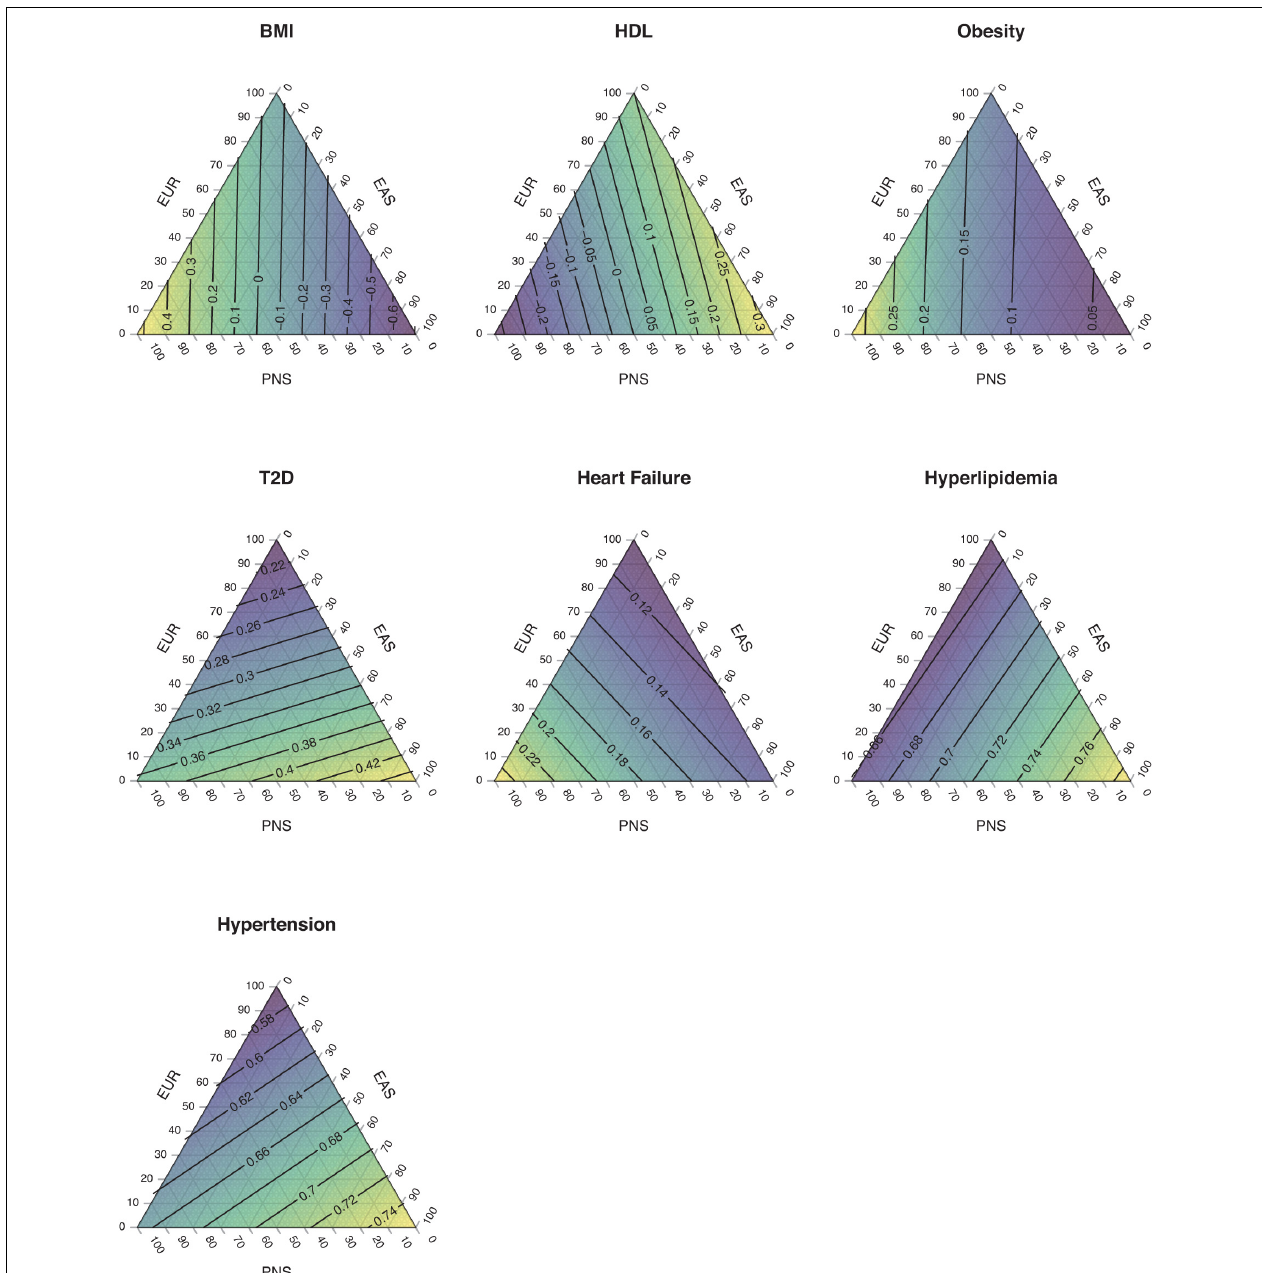
FIGURE 1 | Impact of ancestry components on complex traits and disease risks in Native Hawaiians. The distribution of estimated disease risk are shown as a function of a three-component ancestry model. The linear models used were described in Sun et al. (2021), where for each trait examined as the dependent variable, the effect sizes of the relevant independent variables (e.g., age, BMI, and estimated genetic ancestry as scalar variables, or education level as the categorical variable) were estimated from a Native Hawaiian cohort. Quantitative (BMI and HDL) traits were modeled using linear regression, which predicts the estimated trait value in units of standard deviations given the genetic ancestries. Binary [obesity, type 2 diabetes (T2D), heart failure, hyperlipidemia, and hypertension] traits were modeled using logistic regression, which predicts the probability of disease given genetic ancestries and other covariates. An adult male with age = 50 years, BMI = 30 units (excluded from the obesity model), and education level = college graduate was assumed for calculating probability of disease or estimated trait value. For simplicity, a three-component ancestry model with contributions only from European (EUR), East Asian (EAS), and Polynesian (PNS) ancestors was assumed for Native Hawaiians. The predicted values were interpolated across all possible combinations of ancestries and shown with contour lines. For example, a hypothetical individual with 80% PNS ancestry, 10% EAS, and 10% EUR ancestry aged 50 years, with BMI 30 and college degree, is predicted to have 35–36% chance of being affected with T2D. Similarly, someone with 10% PNS ancestry, 80% EAS, and 10% EUR ancestry of the same age, BMI, and education level is predicted to have ∼ 42% chance of being affected with T2D. Risk for T2D in Native Hawaiians increases with both PNS and EAS components of ancestry. Note that genetic ancestry captures both genetic and correlated environmental/cultural